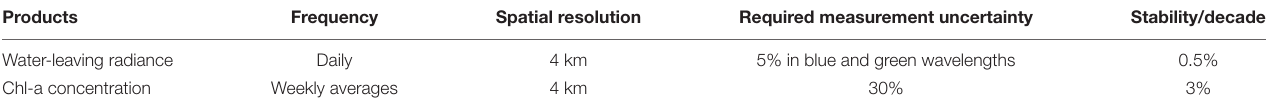
TABLE 1 | The Global Climate Observing System uncertainty requirements for the ocean colour